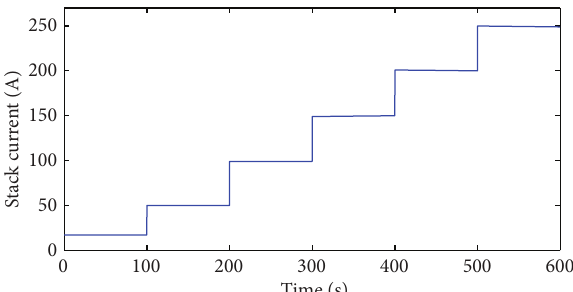
Figure 11: Stack current in the speed-up